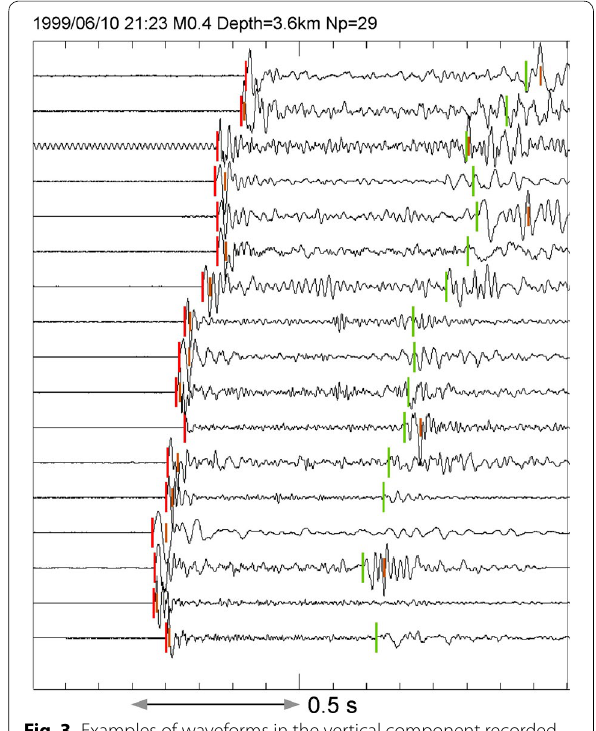
Fig. 3 Examples of waveforms in the vertical component recorded by the high-frequency observation network. Waveforms are displayed in order of epicentral distances. Red and green bars indicate visually picked arrival times of P - and S -waves, respectively. Brown bars indi- cate locations of maximum amplitude. The arrival times of S -waves were picked on transverse components, not shown in this